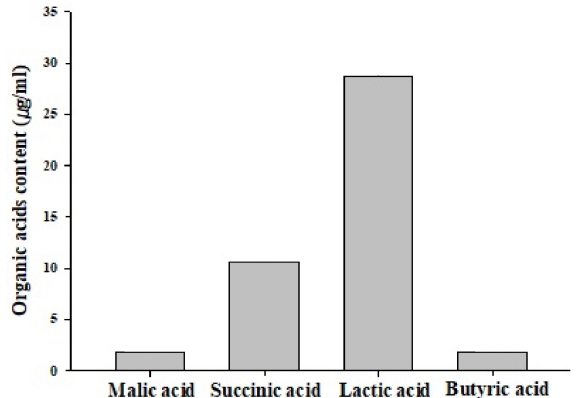
Screening of isolate JW1 on rice